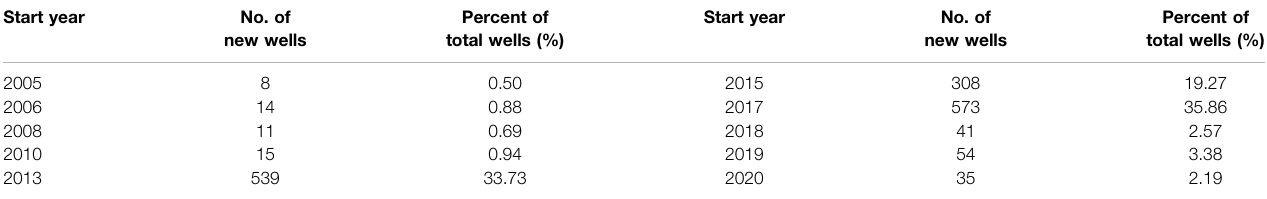
TABLE 1 | Changes in the number of new center-pivot irrigation